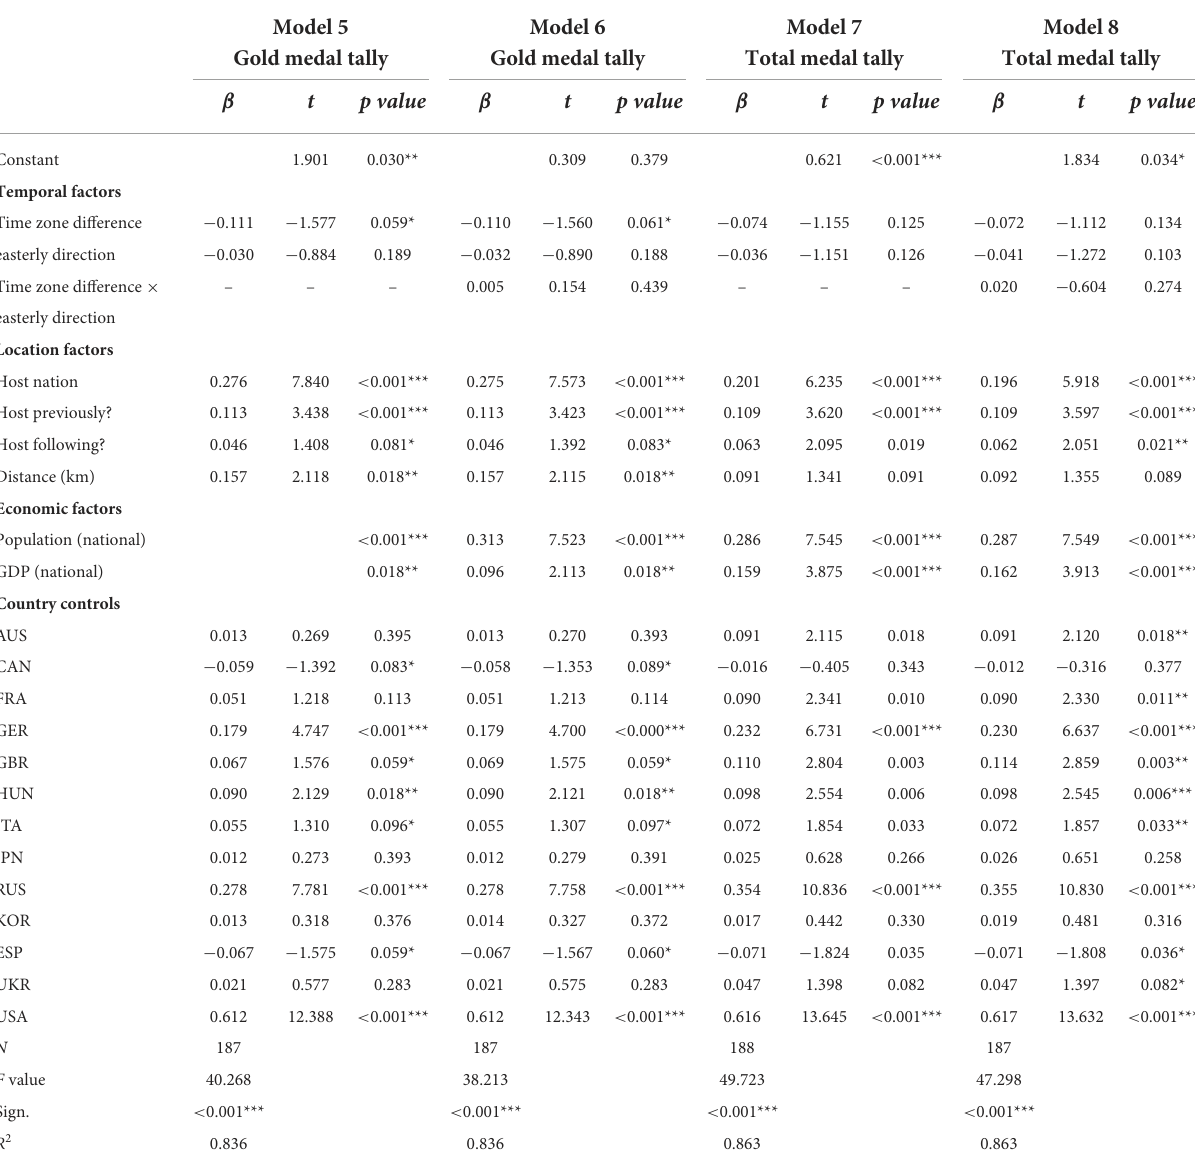
TABLE 4 Multiple regression results for medal